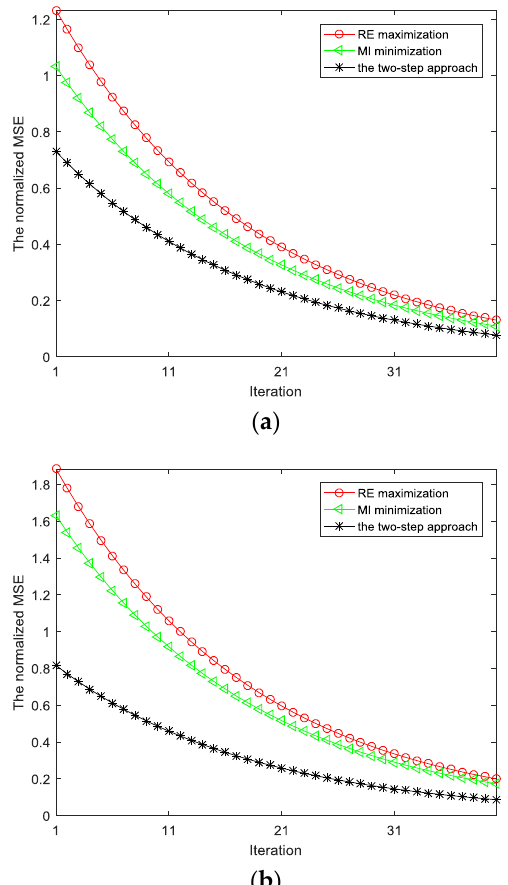
Figure 5. ( a ) The MSE of TIR estimation under power constraint; ( b ) The MSE of TIR estimation under power, PAPR constraint.